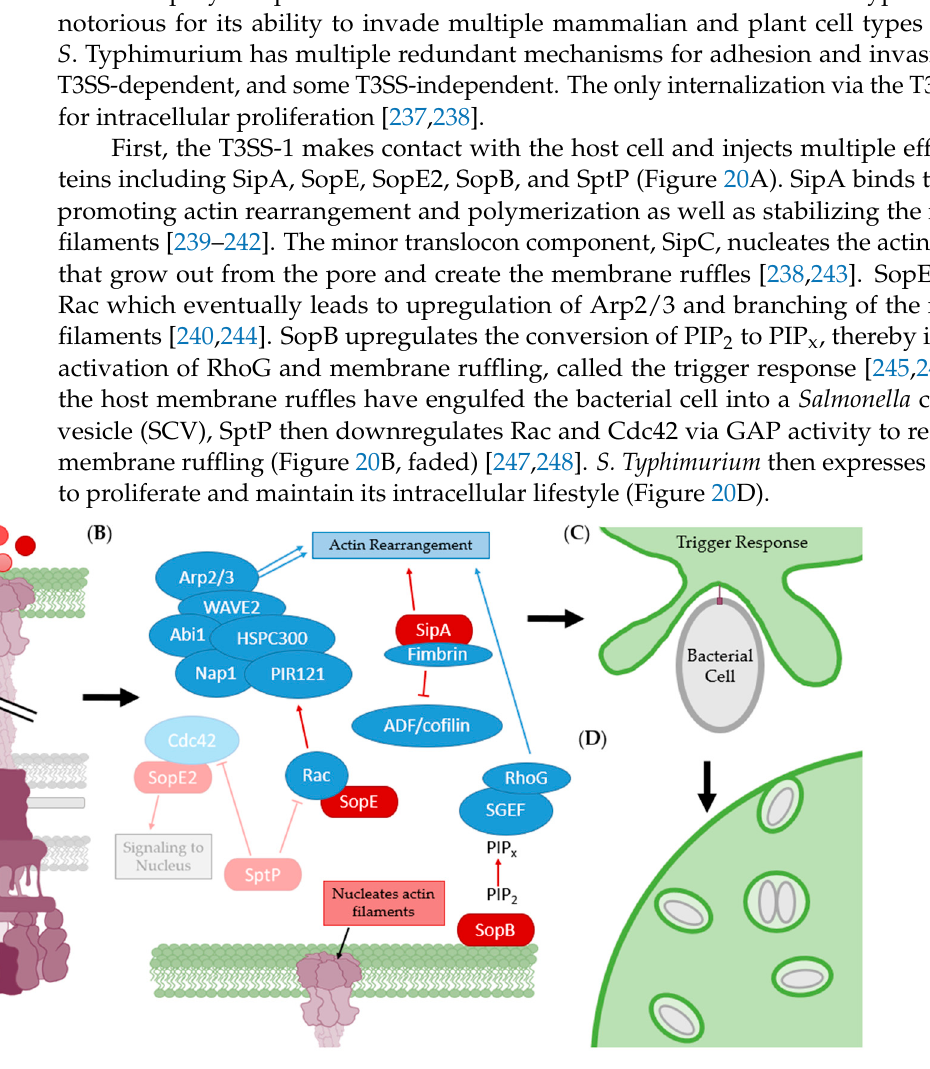
OH Figure 21. Structure of quinine and (-)-epigallocatechin gallate (EGCG). The mechanism of host cell invasion and adhesion by pathogenic bacteria are often related. Inhibitors of the internalization process will potentially be adhesion inhibitors and vice versa. EGCG (Figure 21) has been shown to inhibit T3SS-mediated adhesion and internalization of multiple organisms including EPEC and EHEC, S. Typhimurium, and